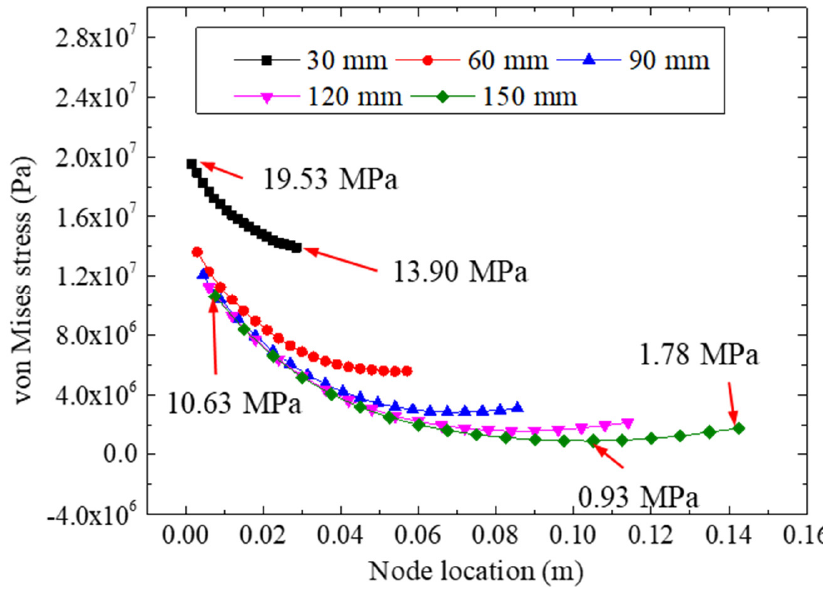
Figure 14. The von Mises stresses for different bonding lengths.